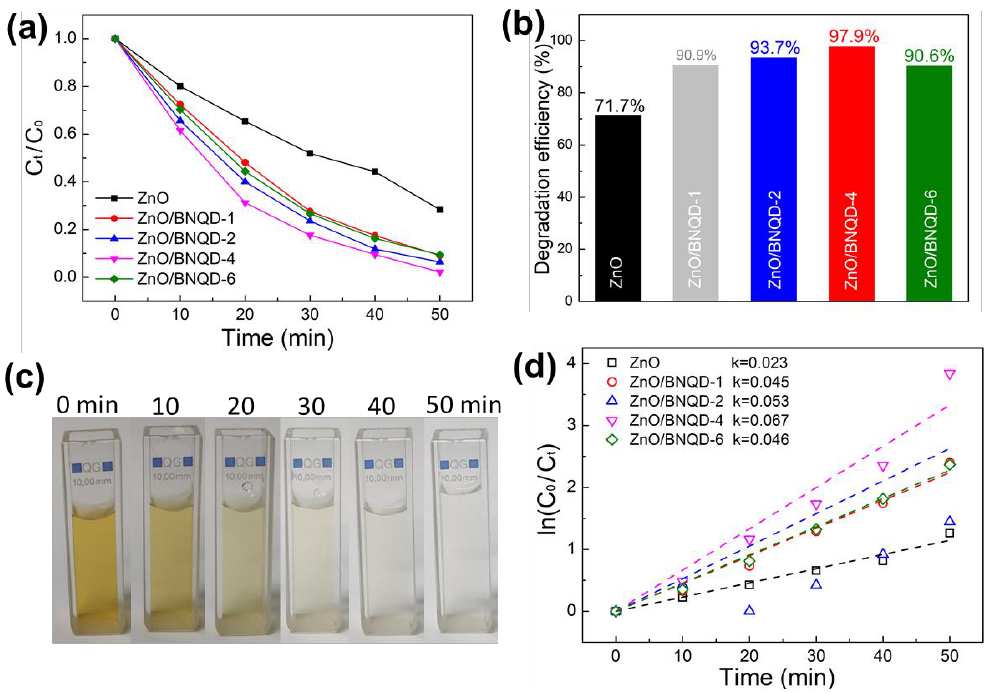
Figure 6. Photocatalytic degradation of MO; ( a ) plots of C t /C 0 vs. UV irradiation time, ( b ) degradation efficiency, ( c ) a photograph of the color change of MO for different irradiation times decomposed by ZnO/BNQD-4, and ( d ) plots of ln(C 0 /C t ) vs. irradiation time.